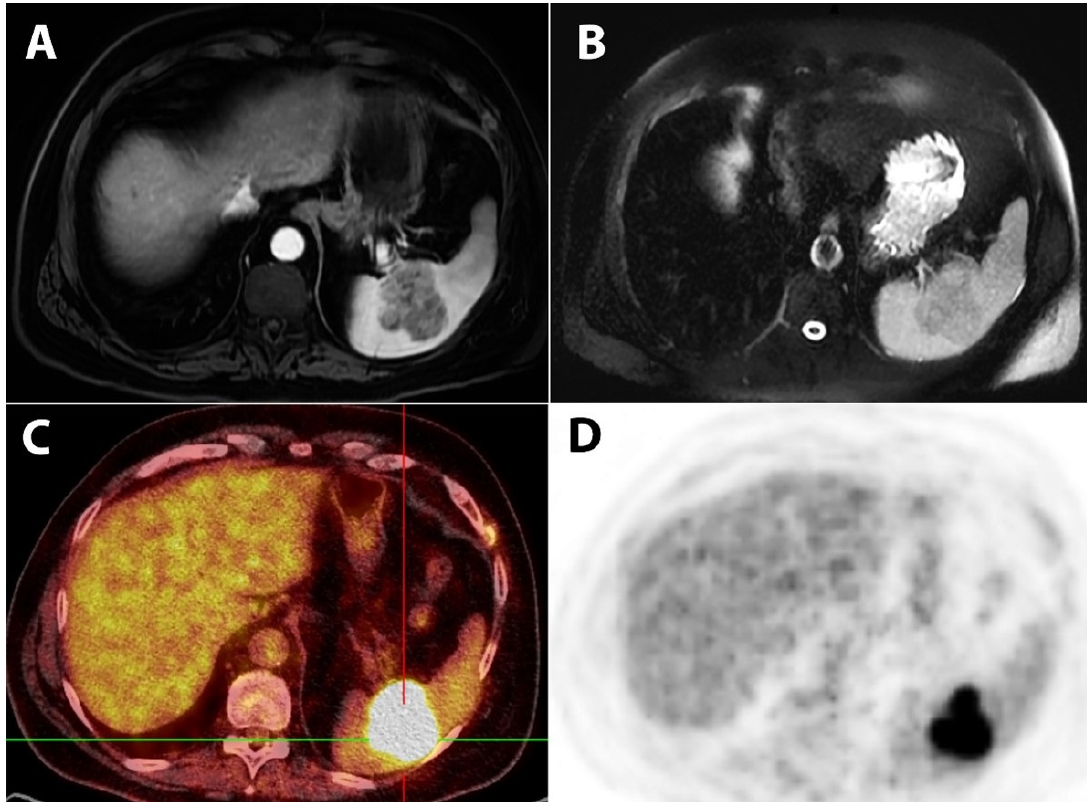
Figure 1. MRI T1-weighted FS image after gadolinium enhancement reveals a predominantly hy- pointense lobulated, relatively homogeneous splenic lesion ( A ) with discrete low signal intensity on T2W. ( B ) FDG-PET/CT ( C ) and FDG-PET axial image ( D ) show a splenic lesion with intensely in- creased FDG uptake.